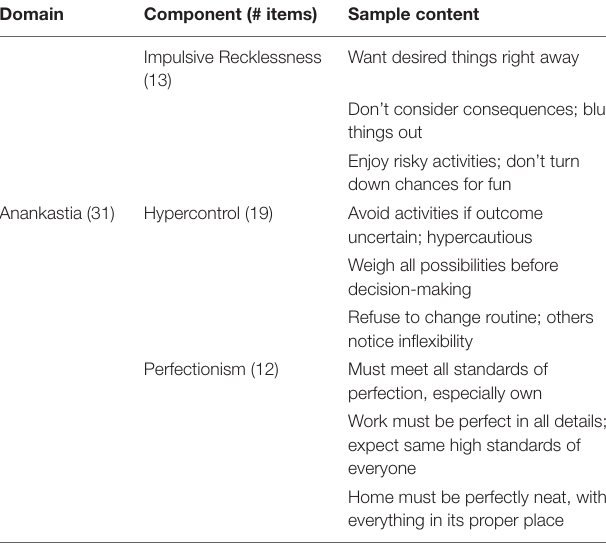
TABLE 2 | Descriptive statistics for the domain and component scales of the ICD-11 PD model.